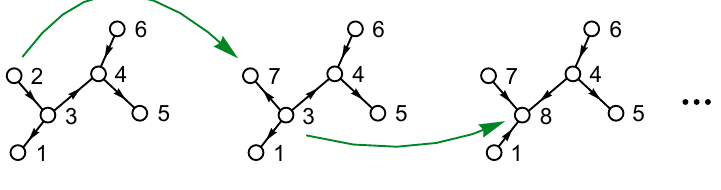
Figure 15 . Walking on a general